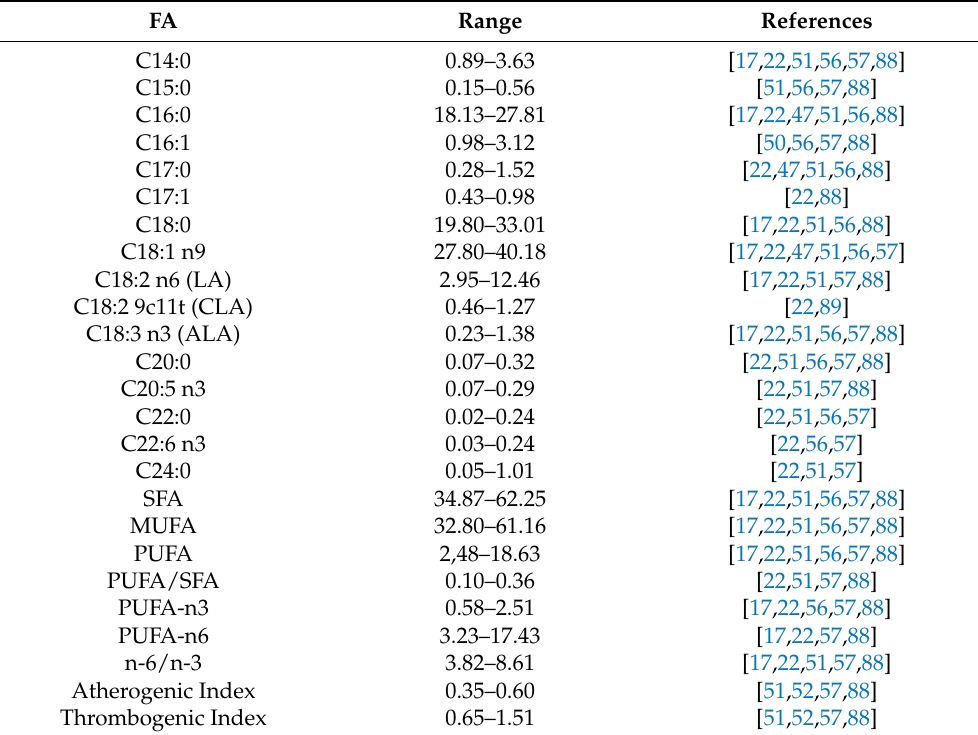
Table 5. The other available data were not disregarded, but considered when useful for specific comments. Table 5. Fatty acid content (g/100 g FAs), fatty acid classes (% total FAs), and nutritional indices of river buffalo